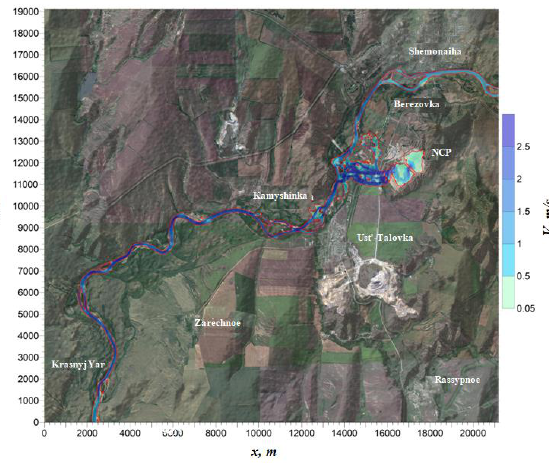
Figure 8. Distribution of the current velocity in the flooding zone during the development of a hydrodynamic accident (Model 3 taking into account the river) at the tailing dump of the processing plant.